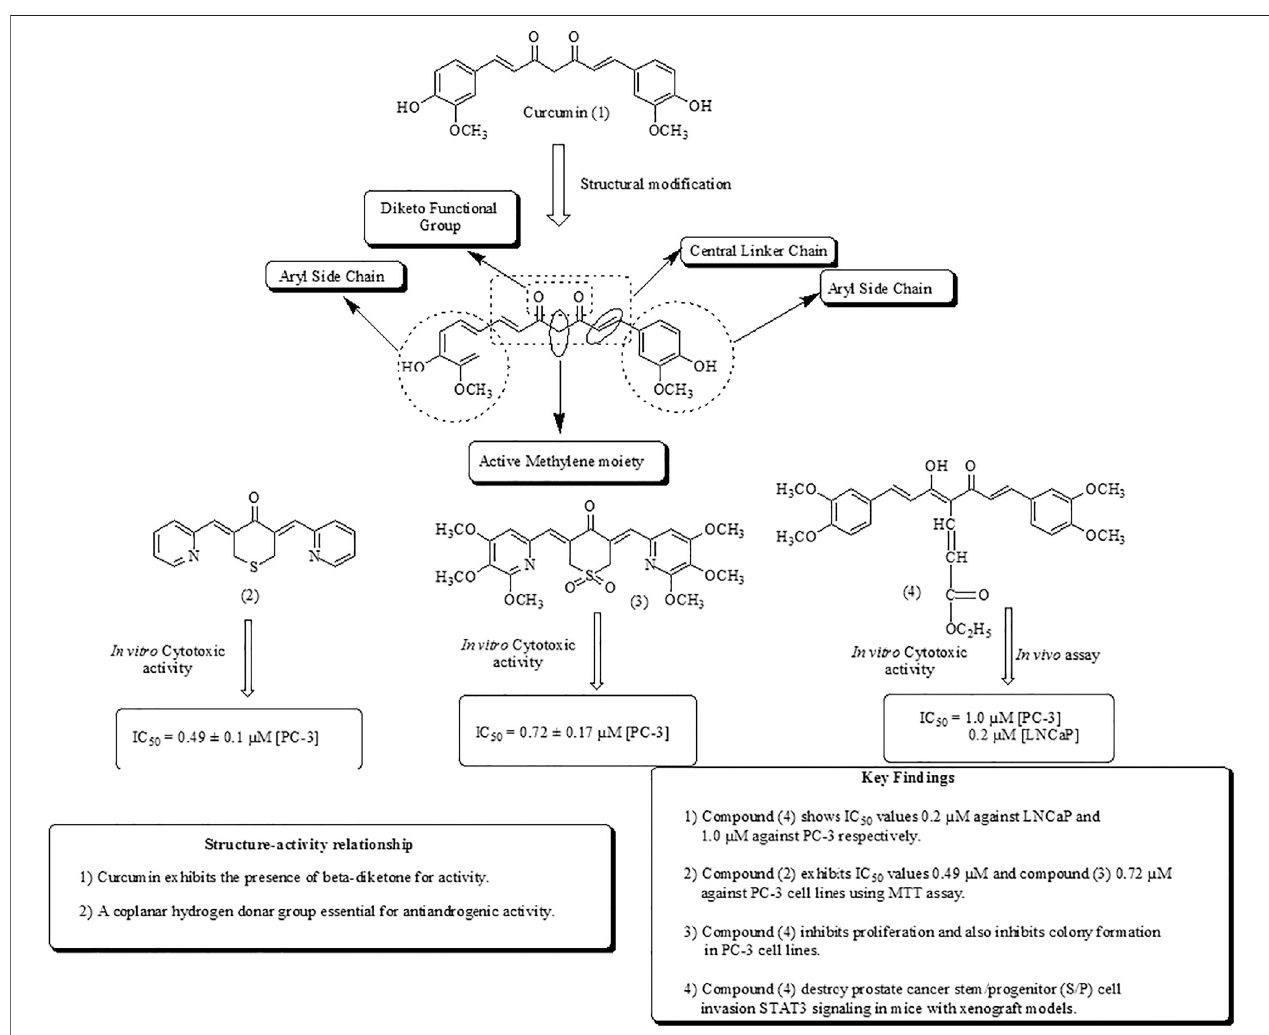
FIGURE 3 | Structure of curcumin along with mechanistic